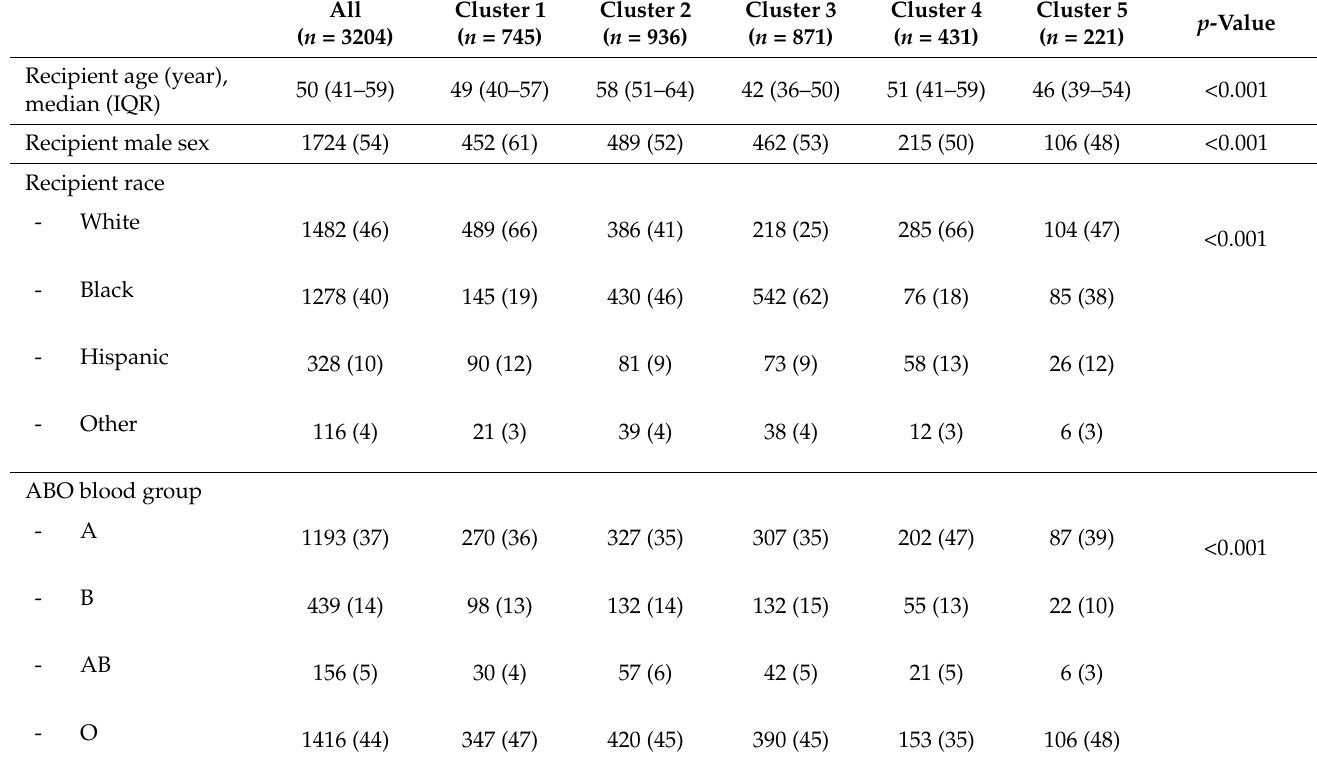
Table 1. Clinical characteristics according to clusters of morbidly obese kidney transplant